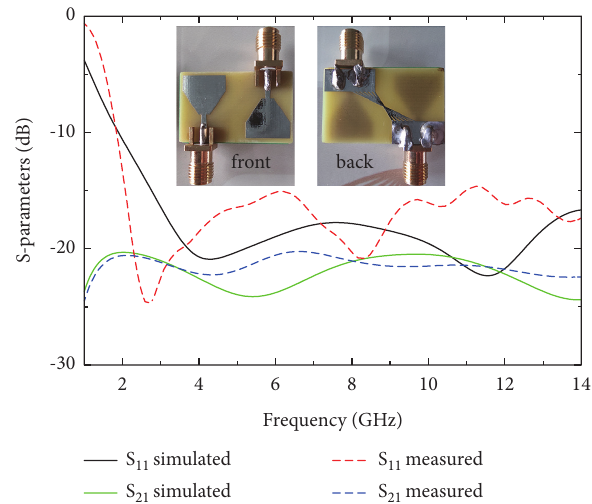
Figure 16: Graph of measured S -parameter results.